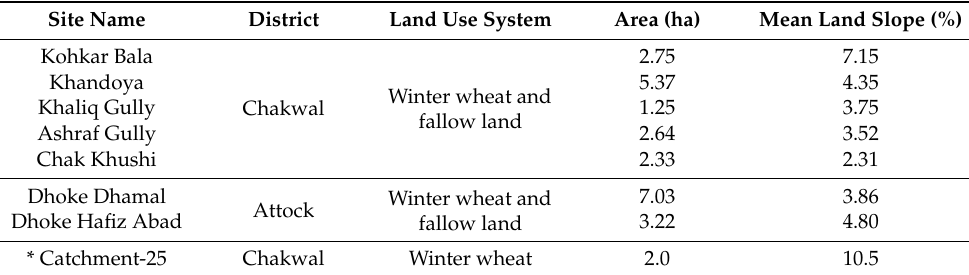
Table 1. Study watershed site descriptions.